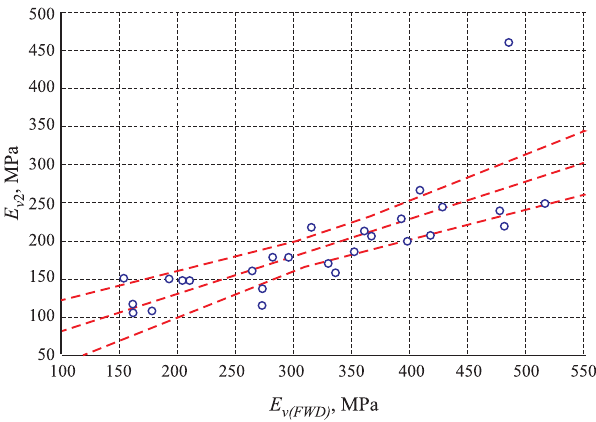
Fig. 3. Correlation between measuring results of the FWD “Dynatest 8000“ and a static beam “Strassentest” on the subgrade of experimental road section in Pagiriai (left side)